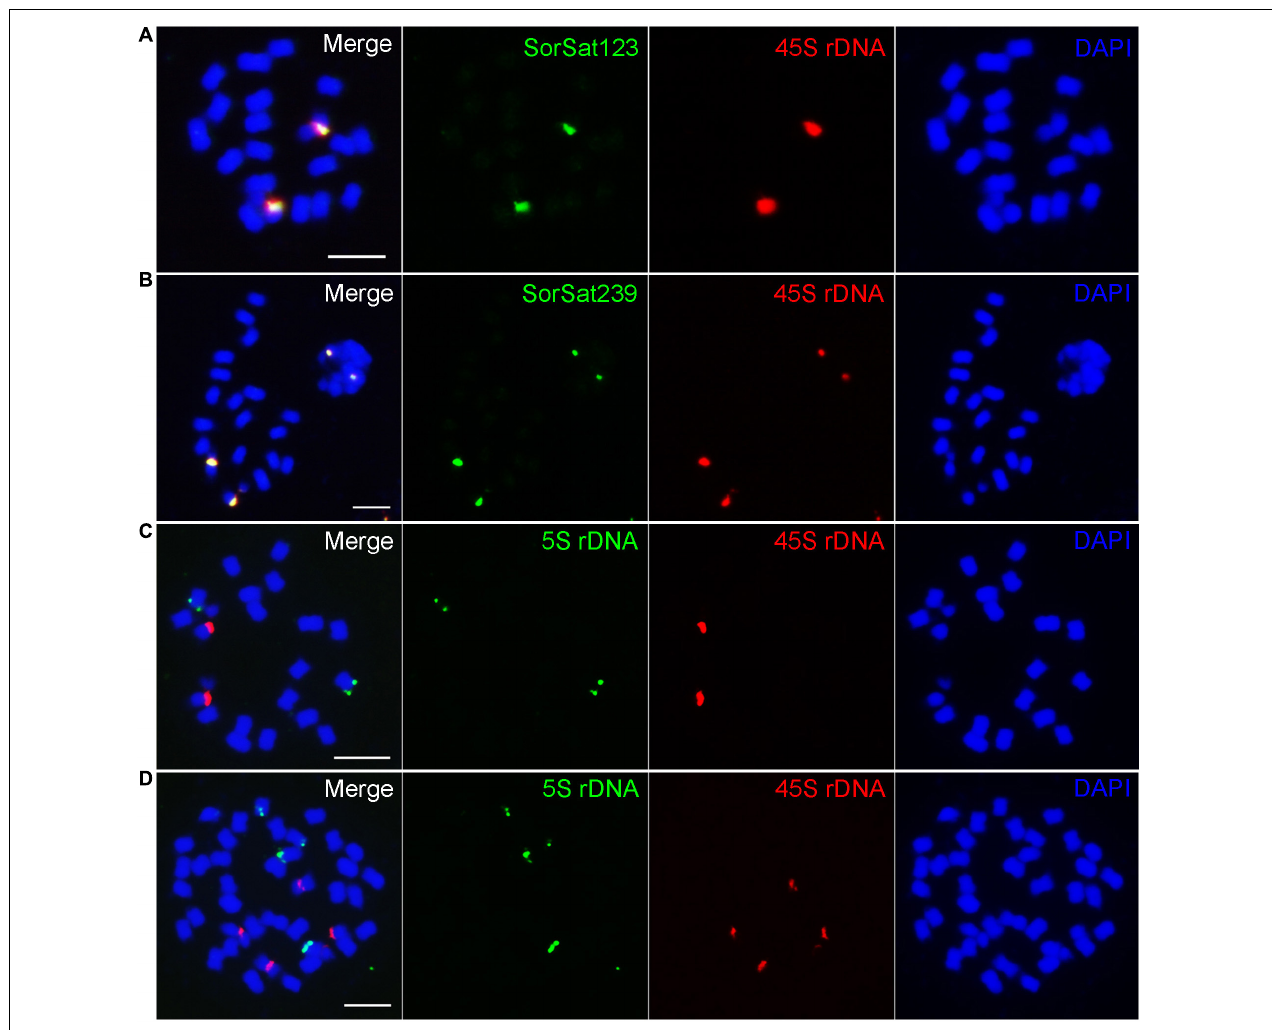
FIGURE 3 | Fluorescence in situ hybridization mapping of the satellite repeats and rDNAs. The satellite (A) SorSat123 and (B) SorSat239 colocalize with 45S rDNA in metaphase chromosomes of S. bicolor . (C) One pair of each 5S and 45S rDNA signal is detected in diploid S. bicolor , while (D) two pairs of signals for both rDNA are present in tetraploid S. halepense . Mitotic metaphase chromosomes were counterstained with DAPI. Bar = 5 µ